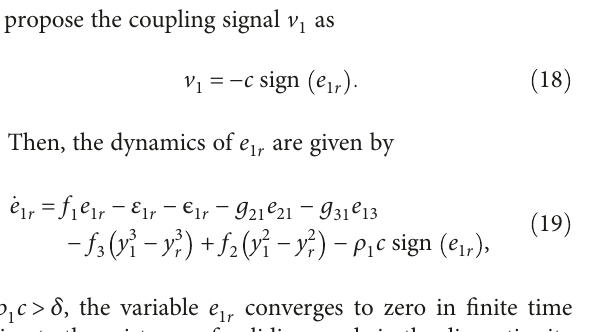
and Σ cells before and after the application of coupling signal v 1 r